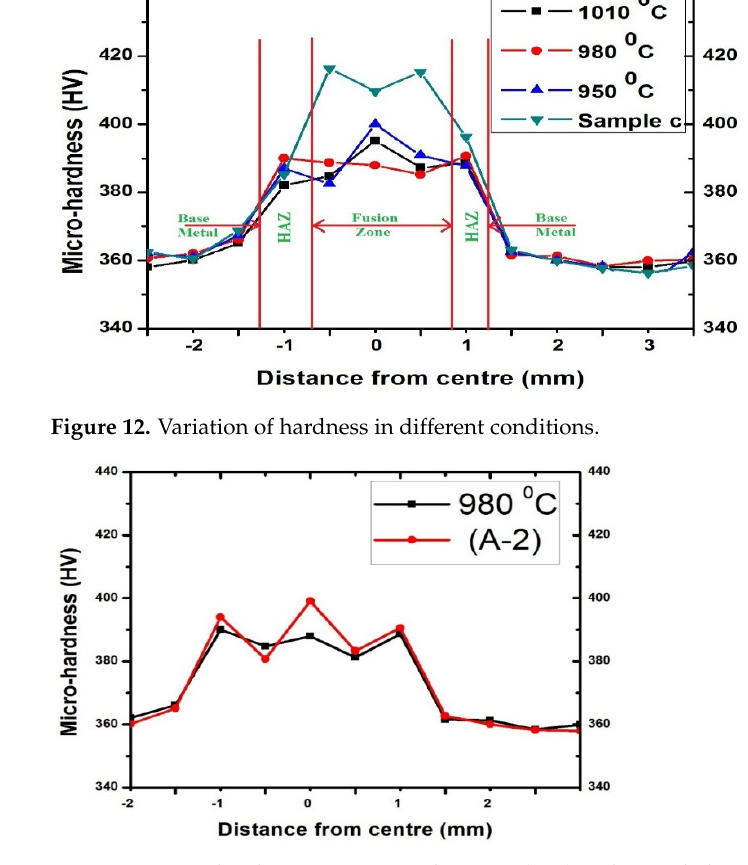
Figure 13. Microhardness comparison between (A-2) and annealed sample at 980 °C.